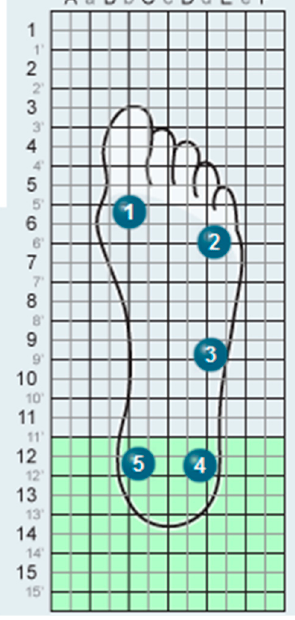
Figure 5. Underfoot WalkinSense sensors placed a screenshot.